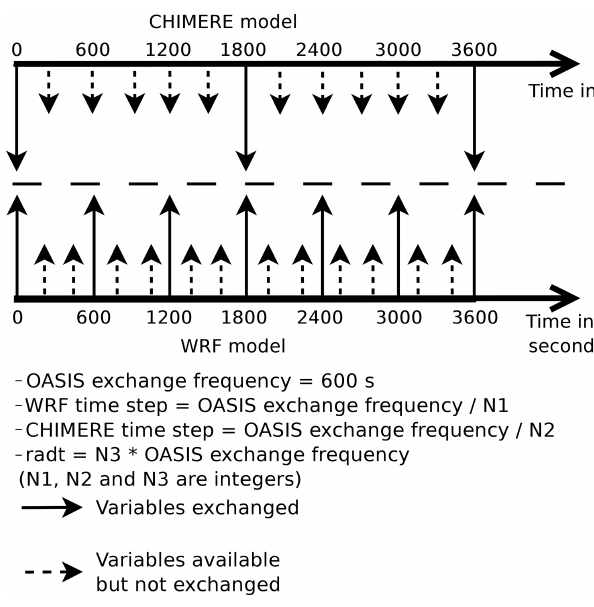
Figure 1. Illustration of variable exchange frequencies. The CHIMERE model receives WRF meteorological fields and sends the aerosol optical properties. The WRF model receives the aerosol optical properties and sends the meteorological fields. The OASIS exchange frequency defines both the frequency at which meteoro- logical fields are exchanged (fixed here at 600s) and the frequency at which aerosol optical properties are exchanged (fixed here at 1800s, with N3 = 3). Both models may perform sub-iterations (here N1 = 3 and N2 = 2), in which case the previously received data are used during the sub-iterations. Note that the OASIS exchange fre- quency along with the N1, N2 and N3 integers are parameters that may be set by